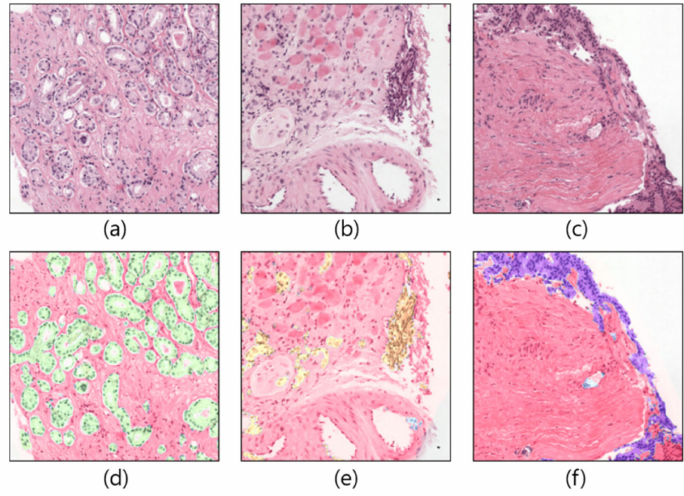
Figure 1. Example of patch images cropped from WSIs. ( a – c ) Original samples. ( d – f ) Corresponding ground-truth samples.